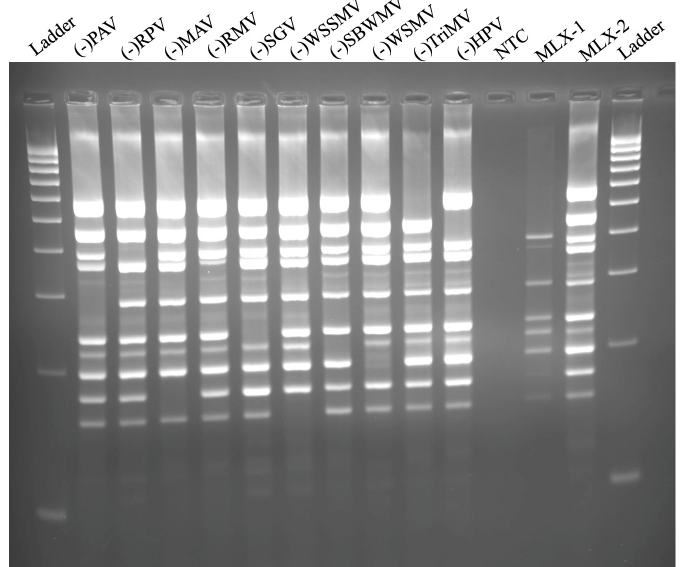
Figure 2. Simultaneous detection of TriMV, HPV, and other wheat viruses from field plant samples using M-RT-PCR. A subset of isolates is shown here: (1) FS 1–2 were received from the state of Texas, (2) FS 3 from Missouri, (3) FS 4 from Oklahoma, (4) FS 5 from Kansas, (5) FS 6 from Oklahoma, and (6) FS 7 from North Dakota. A positive control M-RT-PCR of all ten viruses simultaneously amplified with multiple primer pairs provides a reference ladder (Lane 10). There is lack of amplification of total nucleic acid from healthy wheat sample using all ten primer sets (Lane 9).